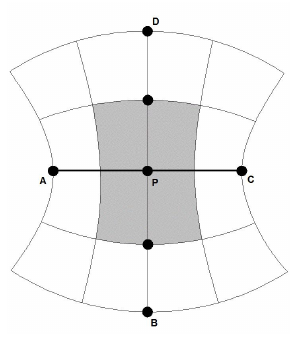
Figure 11: Point between